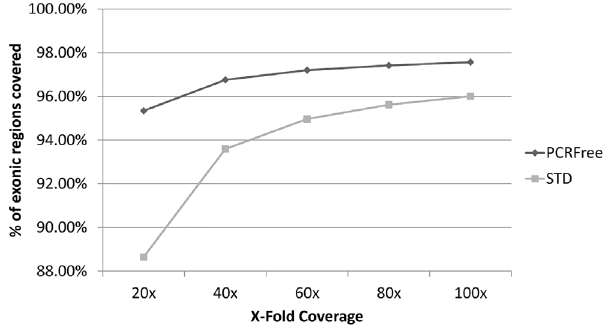
Fig 1. Exonic regions coverage. Percentage of exonic regions covered at a read depth (cid:1) 5, an alignment score (cid:1) 10, a basecall quality (cid:1) 10 from WGS subsets of the original full set with different average X-fold coverage